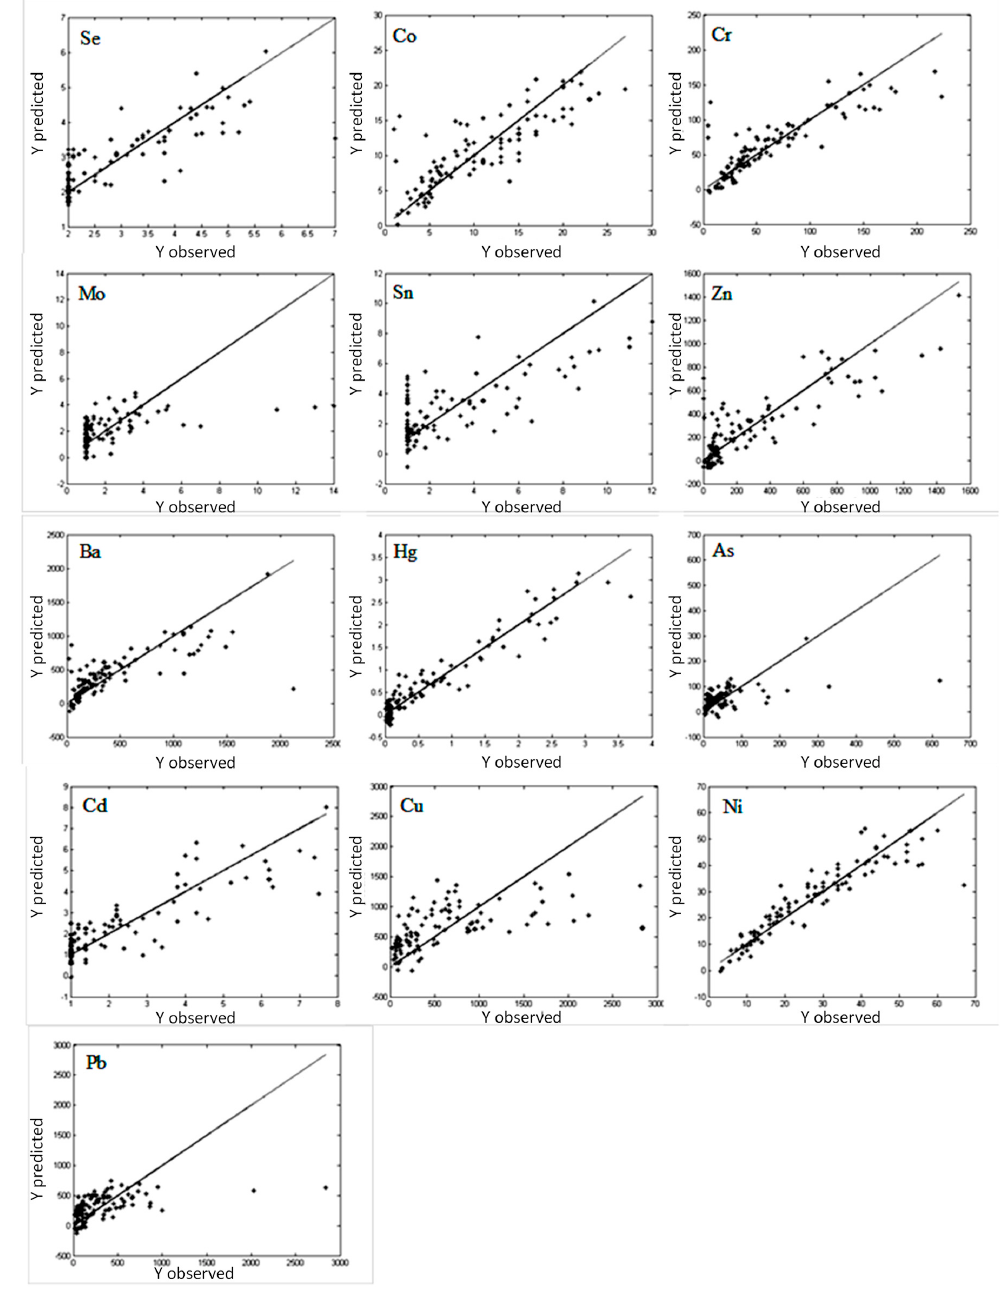
Figure 5. The PLS model describing the relationship between the metal content in soil and the spectral data measured using the ATR in the FIR.